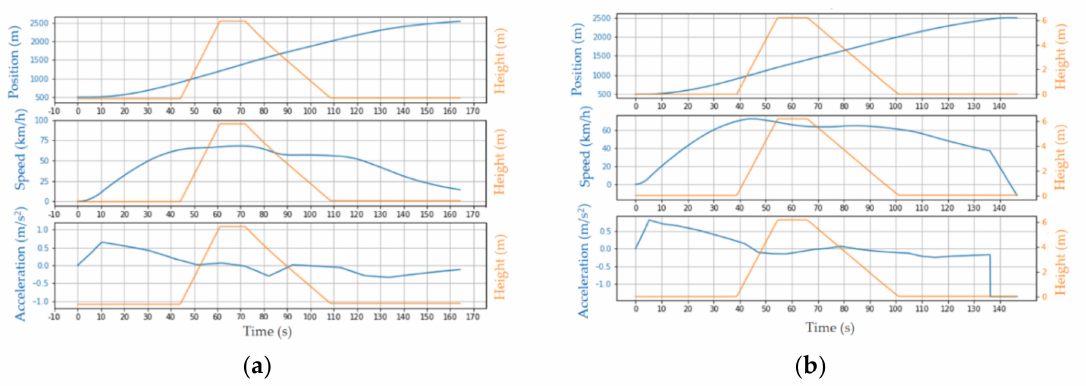
Figure 4. ( a ) The velocity at the end-point is not constrained. ( b ) The velocity is strictly 0 at the end-point.